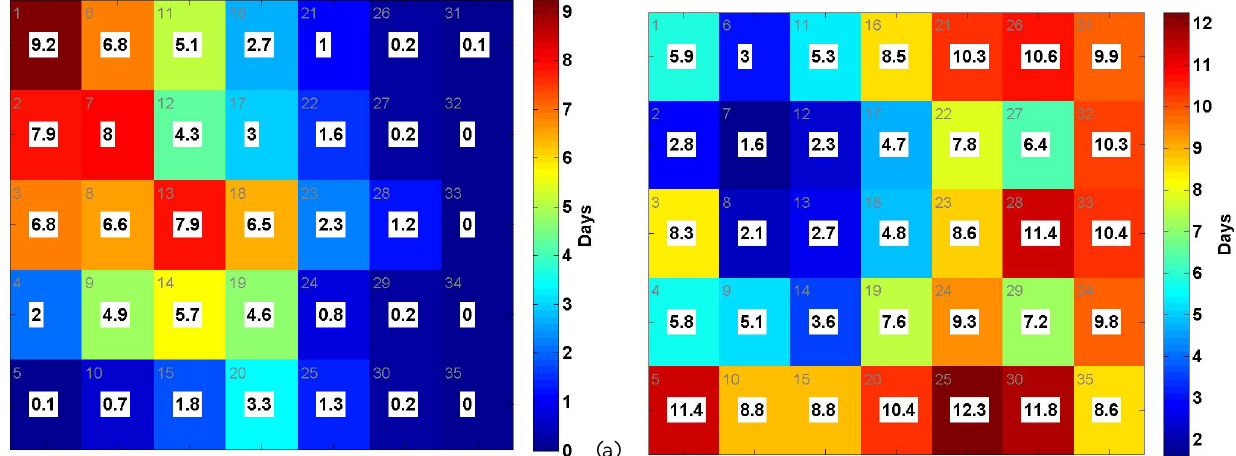
Fig. 4. SOM frequencies in average days per year (1961–2009) during the freezing (a) and thawing (b) seasons. For example, the right-most column in (b) shows that 49 days of the year are controlled by this type of weather, which Fig. 1 indicates as having strong Aleutian lows. These daily averages sum to 365 days. In (a) and (b) , color indicates the same information as the numbers, but this is not the case in the subsequent